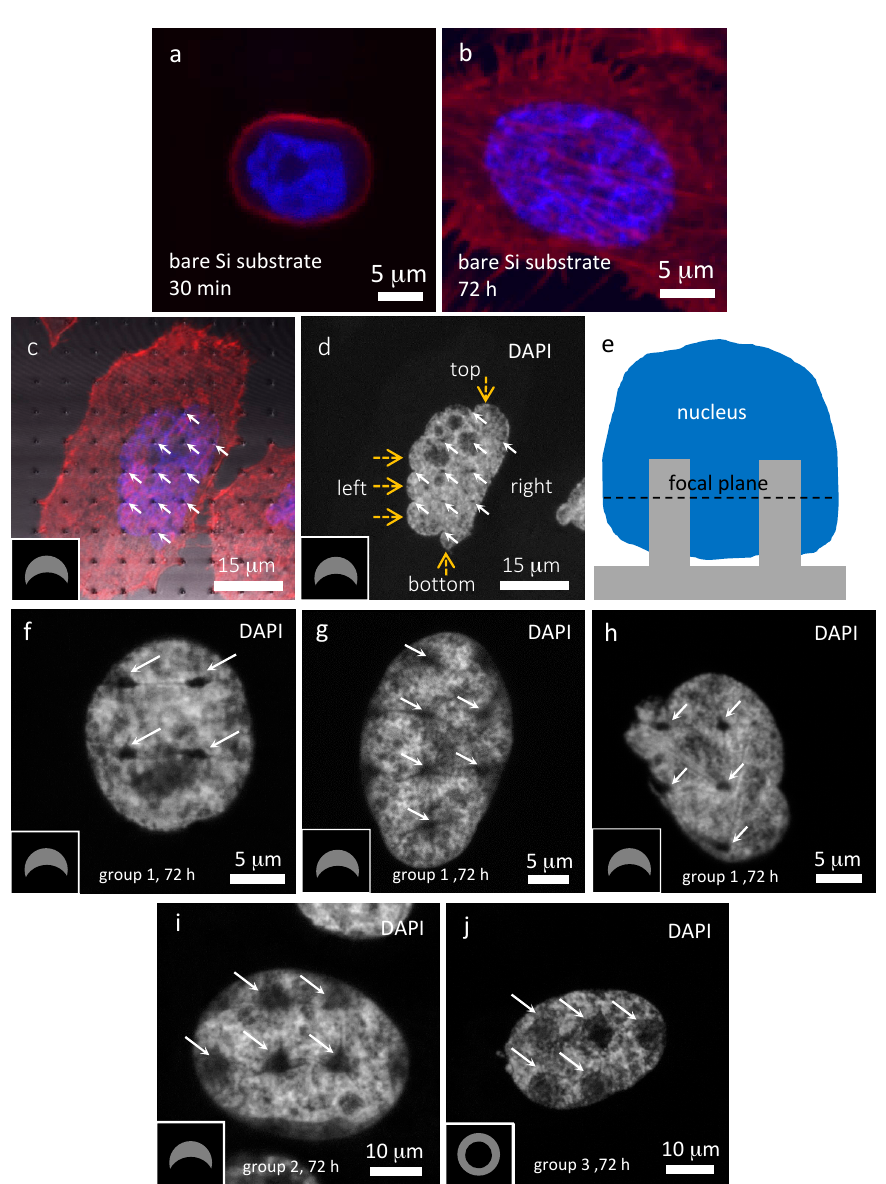
Figure 3. Confocal fluorescence micrographs of PC3 cells incubated for ( a ) 30 min and ( b ) 72 h on bare Si substrate; ( c ) Composite and ( d ) DAPI-only micrographs of PC3 cells incubated for 72 h on small C-shaped pillars (group 1). Pillar locations are indicated by solid arrows while bulged edges of the DAPI-stained materials are highlighted by dashed arrows in ( c ). A schematic drawing of the focal plane used in these micrographs is shown in ( e ). Representative micrographs of PC3 cells incubated for 72 h reveal fine line structures emanating from the small C-shaped pillars are displayed in ( f – h ). Lines in ( f ) are connected with the adjacent pillars while lines in ( g ) and ( h ) are not. Confocal micrographs of 72 h incubated PC3 cells on large C-shaped and hollow-shaped pillars are displayed in ( i , j ), respectively. Inset drawings indicate the pillar orientations.